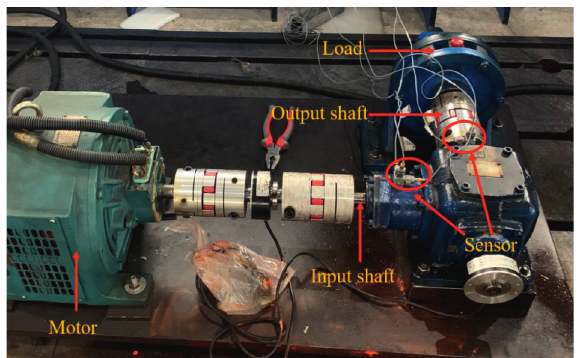
Figure 11: Spiral bevel gearbox test